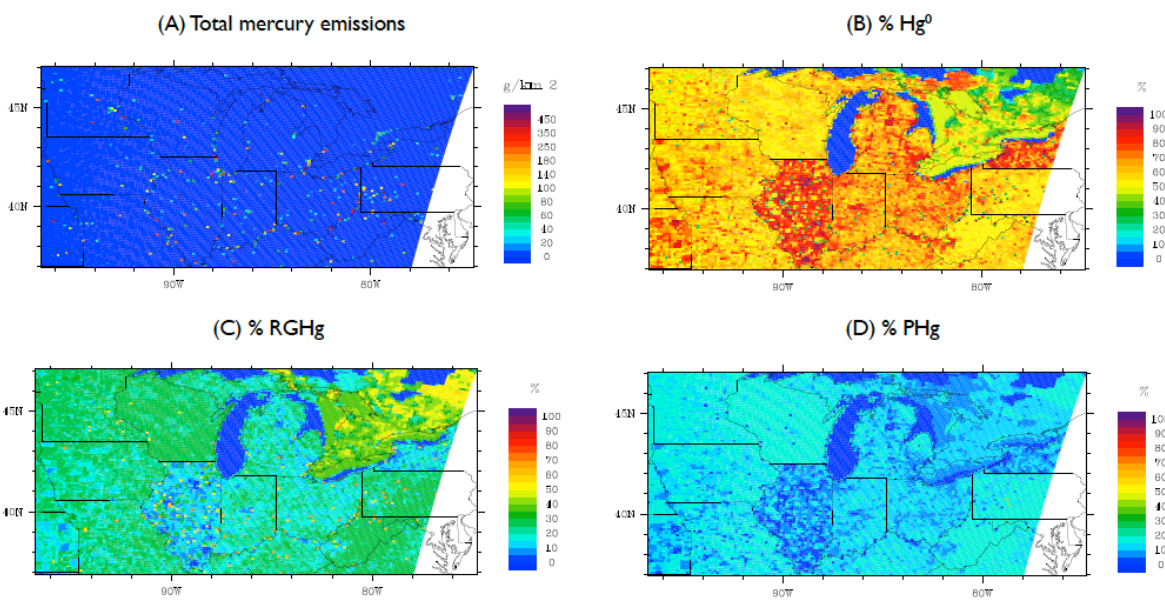
Fig. A1. Mercury emissions used in CMAQ-Hg, taken from the 1999 EPA National Emissions Inventory (NEI) and processed through the SMOKE model. Total mercury emissions (a) are given in gkm − 2 , as well as percent (%) allocation to Hg 0 (b) , RGHg (c) and PHg (d)